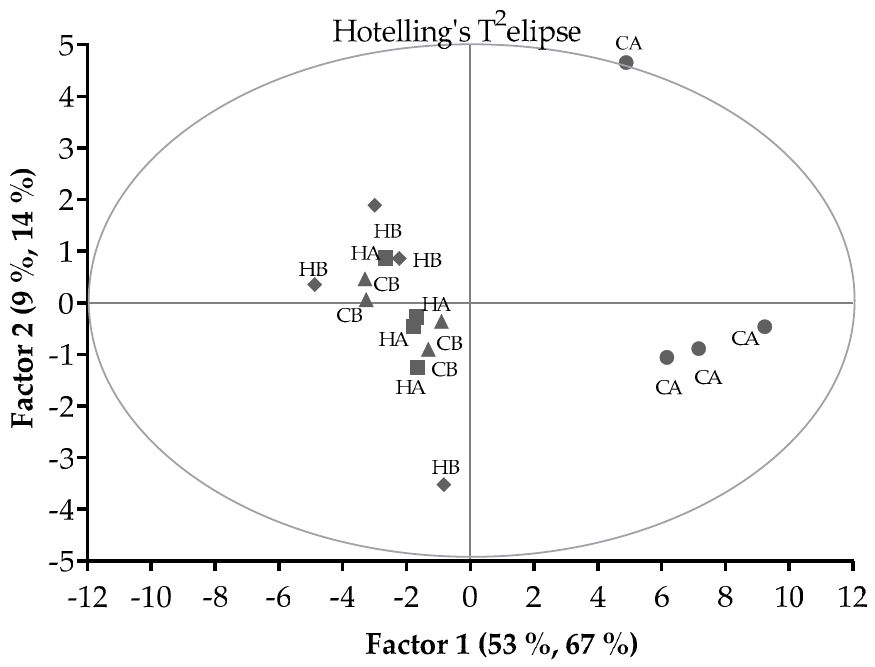
Figure 2. Pattern of relationships between the Control pellets stored at ambient temperature (CA) or 5 °C (CB) and H57 inoculated pellets stored at ambient temperature (HA) or 5 °C (HB) in a score plot of the PLSR analysis. Hotelling’s T 2 ellipse indicated the outlier with critical test value at α = 0.05 .